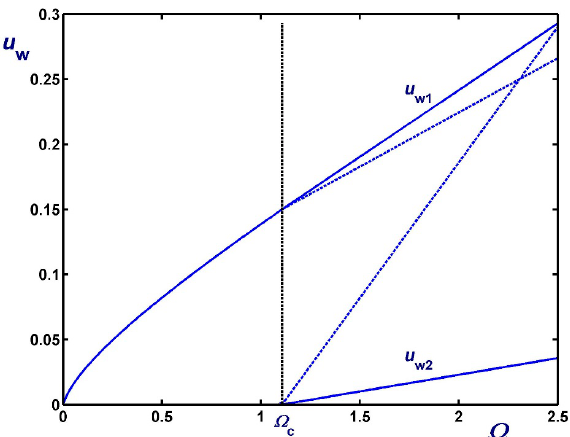
Figure 11. Slip velocities for κ = 0.5, B 1 = 0.1 and B 2 = 0.1 (moderate slip along both cylinders, solid) κ= = = Figure 11. Slip velocities for 0.5 , 1 0.1 B and 2 0.1 B (moderate slip along both and B 2 = 1 (strong slip along the outer cylinder, dashed) in the case of non-zero slip yield stress τ ∗ c = τ ∗ = cylinders, solid) and 2 1 B (strong slip along the outer cylinder, dashed) in the case of non-zero The critical angular velocity is Ω c = 1.10685. τ τ= Ω = slip yield stress * * 0 c . The critical angular velocity is 1.10685 c .